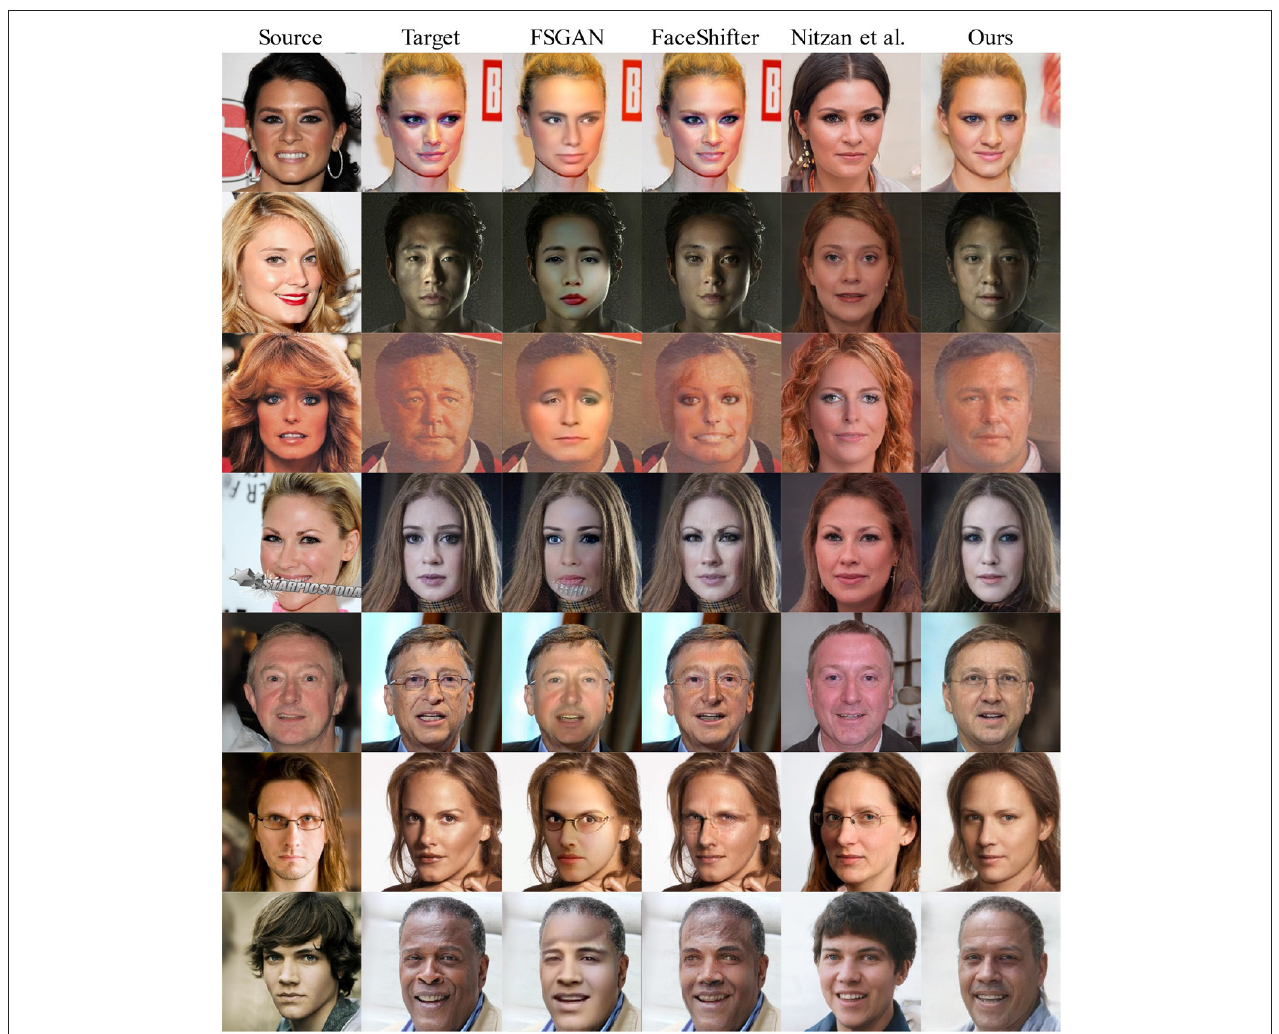
FIGURE 3 | Qualitative comparison with FSGAN (Nirkin et al., 2019), FaceShifter (Li et al., 2019; Nitzan et al., 2020) on the CelebAMask-HQ (Lee et al., 2020) test dataset.